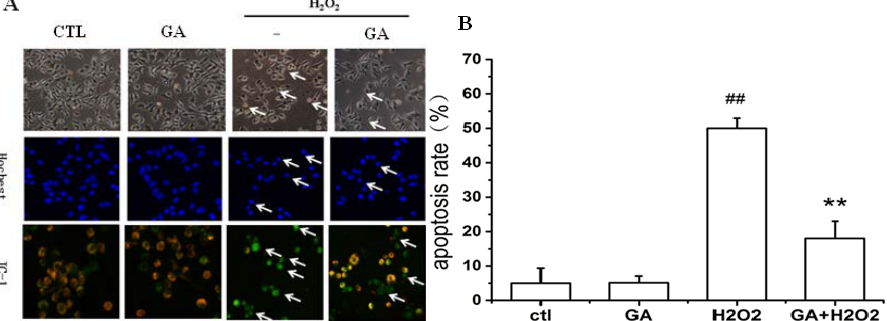
Figure 3. GA inhibited the apoptosis of RGC-5 cells induced by H 2 O 2 . RGC-5 cells were pre-incubated with or without GA (10 μM) for 2 h before the addition of 100 μM H 2 O 2 . Cells were incubated with Hoechst 33,258 staining. ( A ) Morphological changes shown by fluorescence microscope (200 × ) image analysis; ( B ) Histogram showing the apoptosis rate of RGC-5 cells after H 2 O 2 exposure in the presence or absence of GA compared to H 2 O 2 -treated control group. The results shown were from a representative experiment, which was repeated at least three times. ## p < 0.01 vs. control group; ** p < 0.01 vs. H 2 O 2 -treated group. Arrows in the first row pointed to represented cells with morphological changes; arrows in the second row pointed to represented apoptotic cells without blue color; arrows in the third row pointed to represented apoptotic cells with green